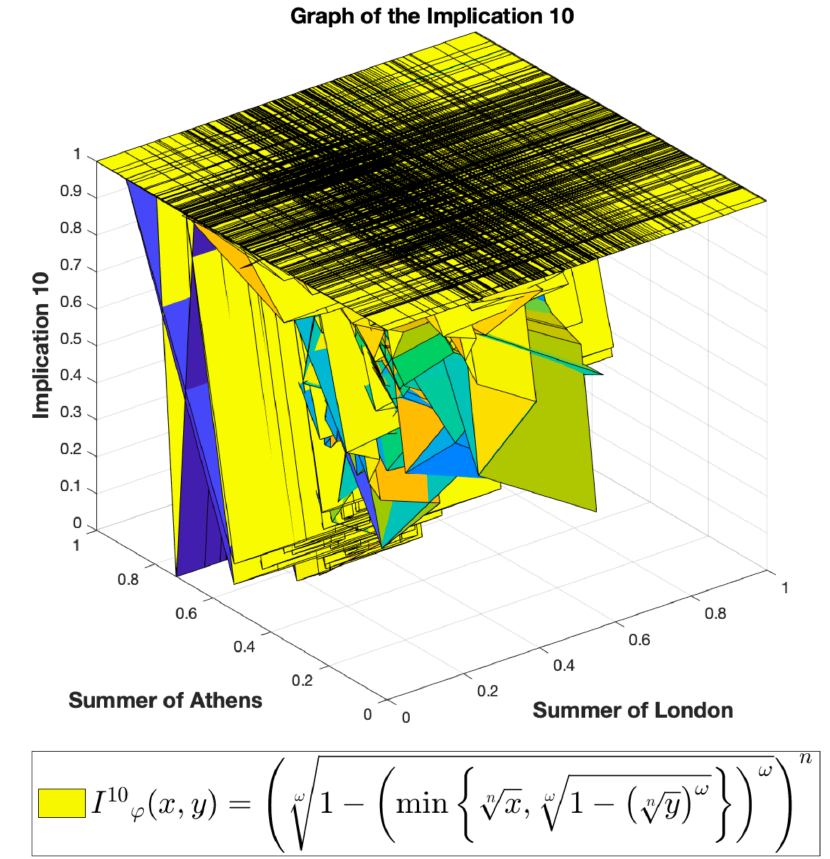
Figure 13. Graph of the Implication